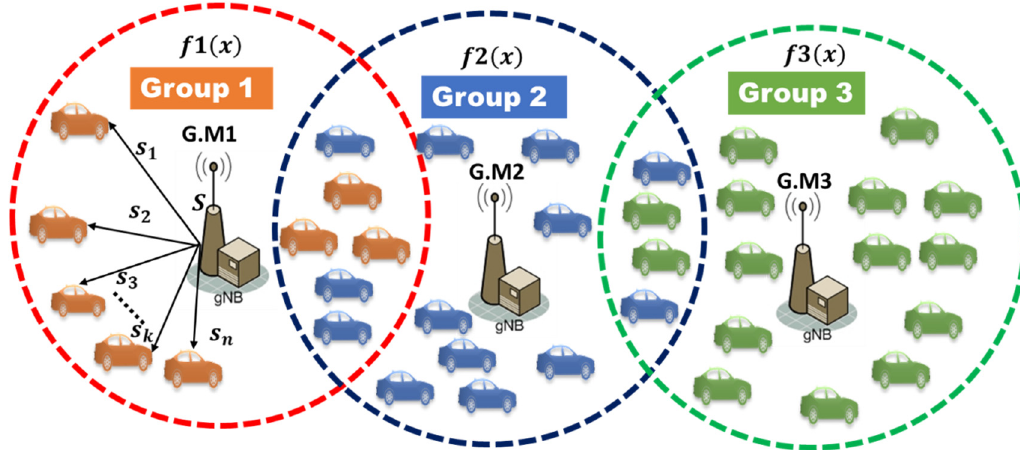
Figure 2. The proposed network system model.